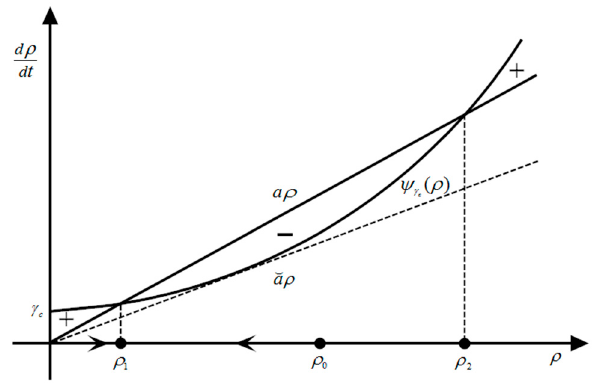
(cid:94) a , ρ 1 , ρ 2 .